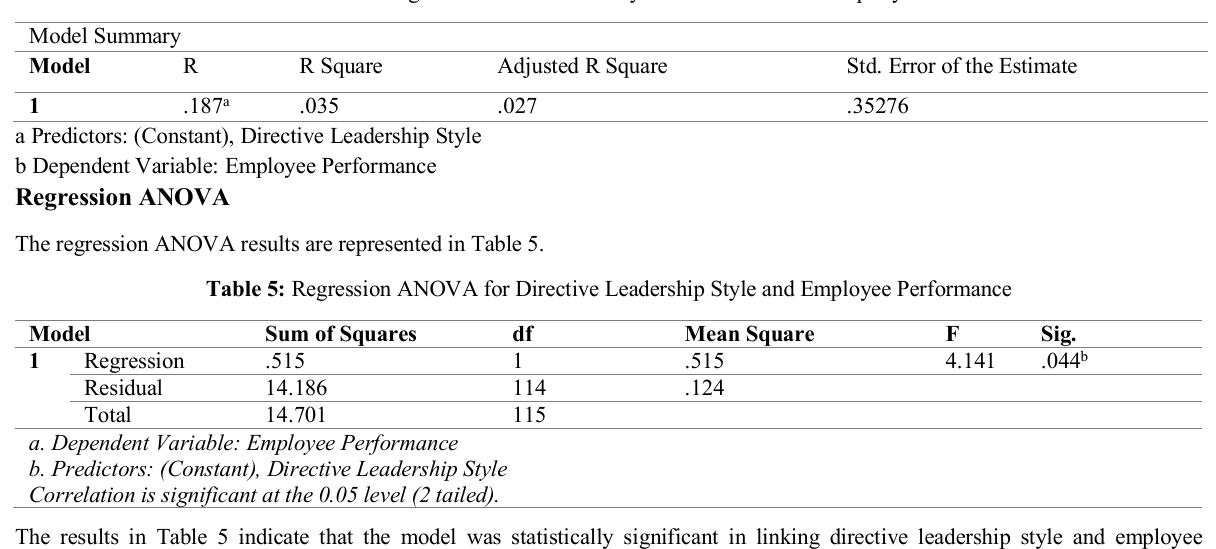
Table 4: Regression Model Summary for Directive Leadership Style